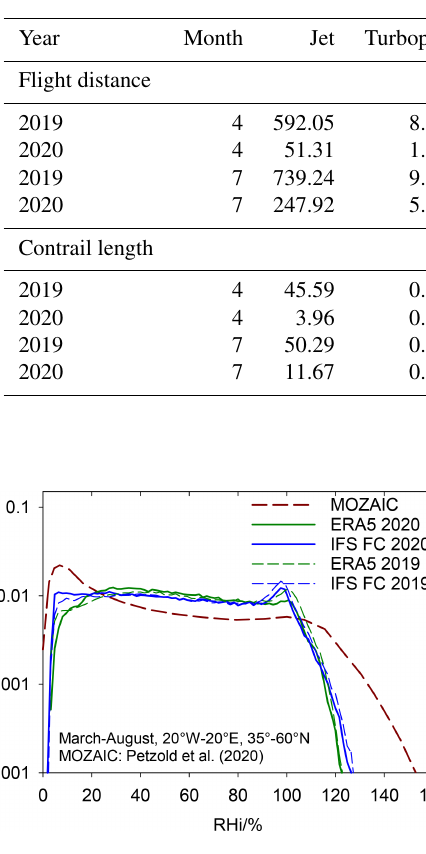
Figure 4. Probability density of relative humidity over ice (RHi) from ECMWF IFS forecast data (FC, blue lines) and ERA5 re- analysis data (green) along the traffic routes over Europe as in 2020, evaluated separately for the meteorology of 2019 and 2020. The dark red dashed curve represents the 1995–2010 MOZAIC data as in Fig. 5a of Petzold et al. (2020).